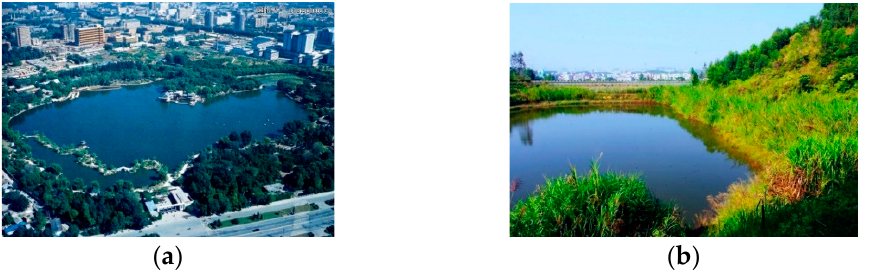
Figure 13. Spatial forms of water areas: ( a ) water area in a city; ( b ) water area in the countryside.